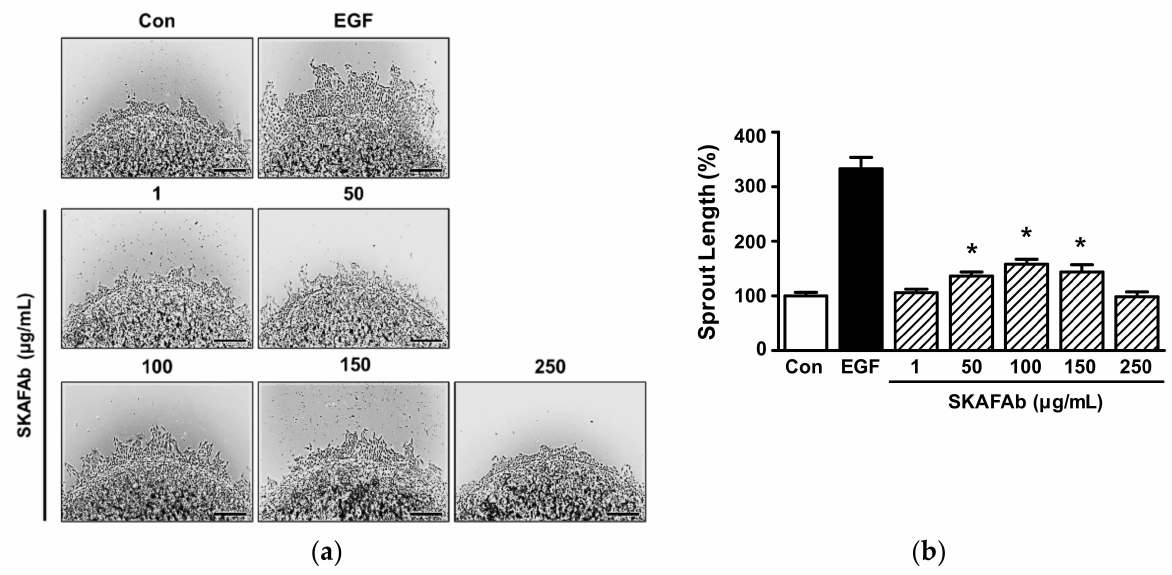
Figure 4. Effect of Salix koreensis Anderss flower absolute on keratinocyte sprout formation. ( a ) HaCaT cells mixed with collagen were spotted on a 24-well plate and incubated with or without Salix koreensis Anderss flower absolute (SKAFAb; 1–250 µ g/mL) for 48 h. Cells were fixed and stained with Diff- Quick solution and photomicrographs were taken. Recombinant human epidermal growth factor (rhEGF: 50 ng/mL) was used as a positive control. Sprout lengths were measured using Image J. Scale bar = 100 µ m. ( b ) Statistical graph. Percentages are of levels versus untreated cells (Con). Results are presented as means ± SEMs ( n = 4). p -values by one-way ANOVA are <0.0001. * p < 0.05 vs. untreated cells (by a Tukey’s post hoc